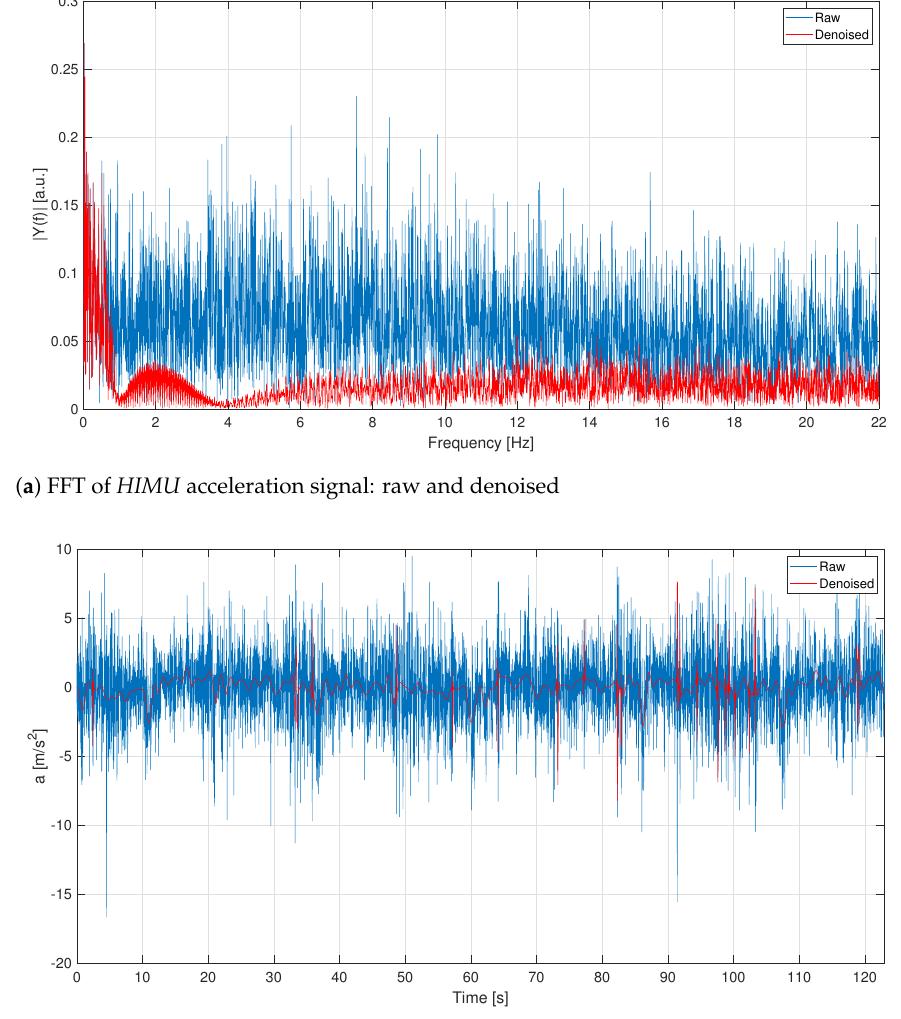
Figure 8. C1—Comparison between raw and denoised